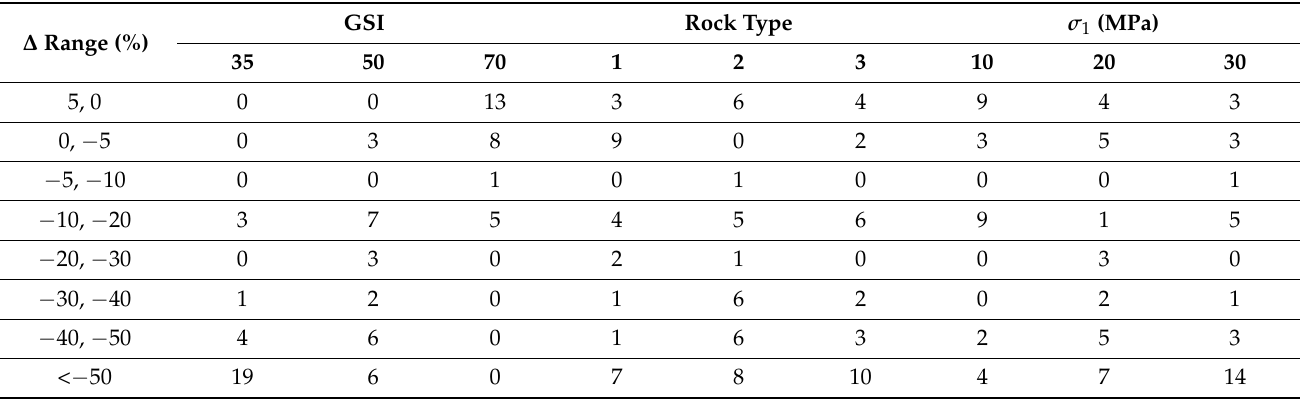
Table 6. Number of cases in the various error ranges for maximal differential stress at the boundary of the excavation.